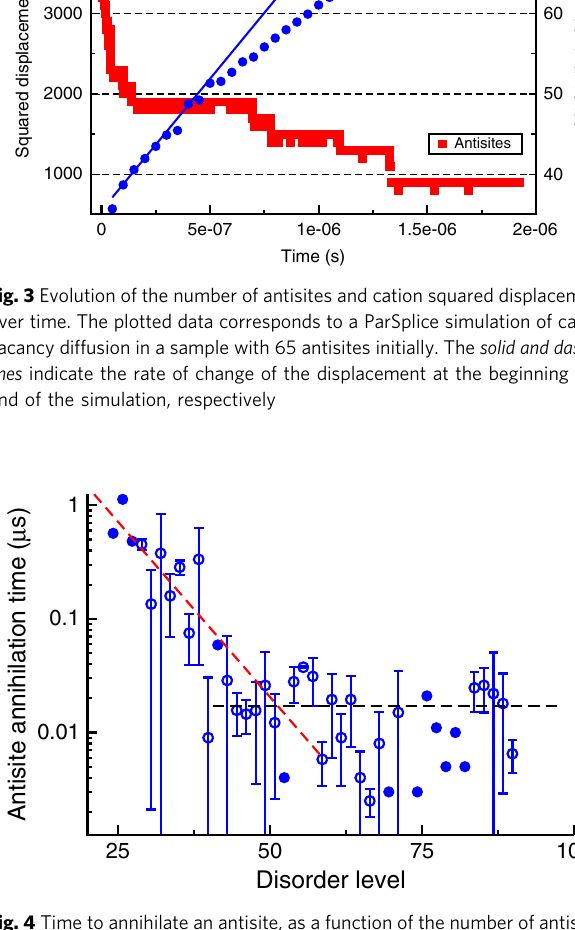
Fig. 4 Time to annihilate an antisite, as a function of the number of antisites in the system. Closed symbols denote cases for which only one data point is available, i.e., the transition n → n − 1 antisites was observed only once over all simulations. Error bars re fl ect the standard error for averaged values, when more than one data point was available. The red dashed line is obtained by fi tting an exponential function, and the black dashed line by fi tting to a constant